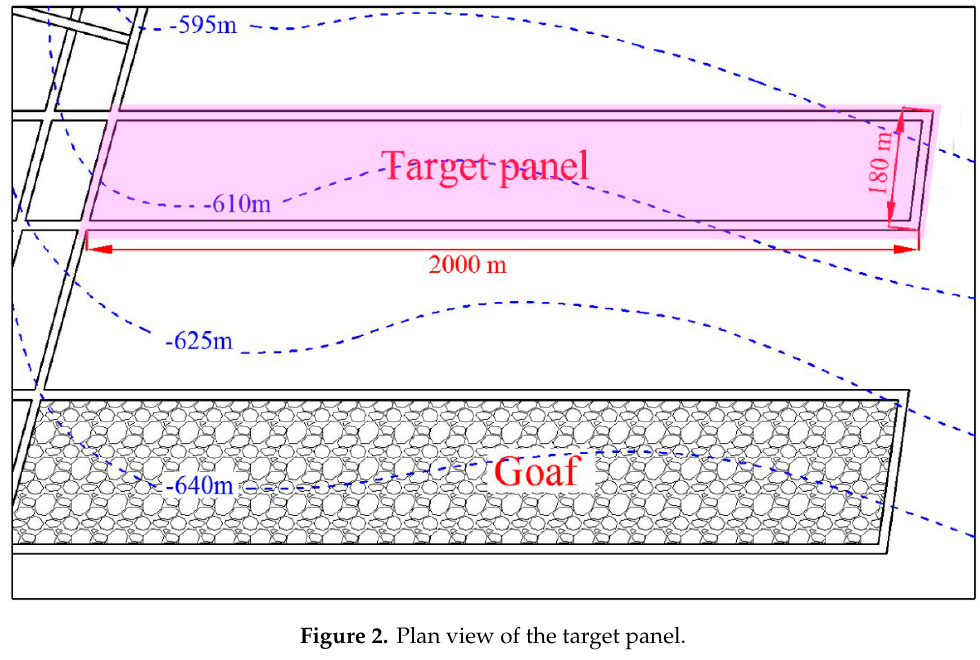
Figure 2. Plan view of the target panel.